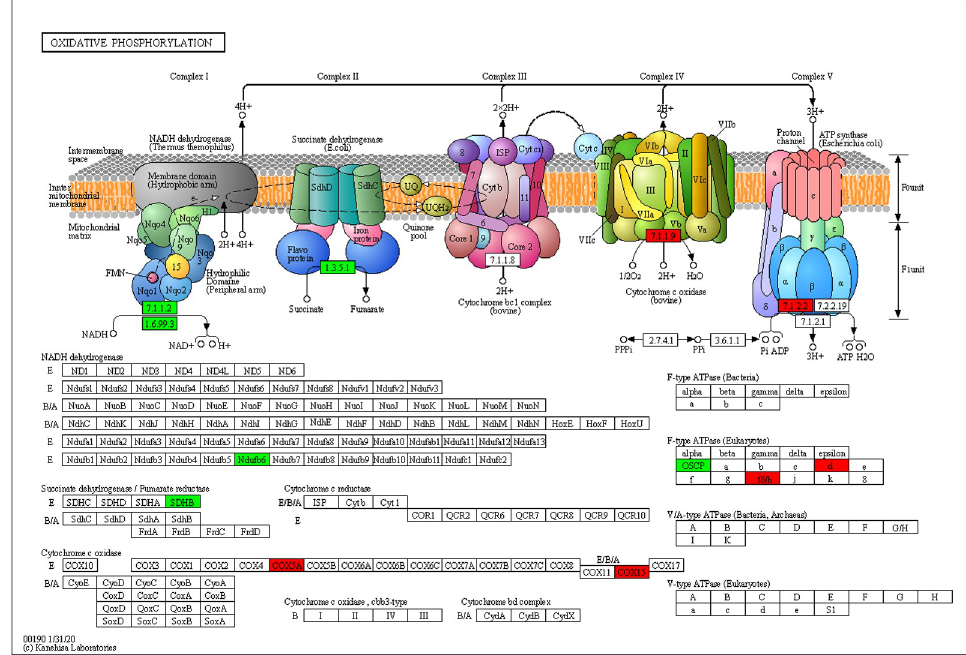
Fig 3. C . parvum affected the oxidative phosphorylation process of host cells. The protein names in red showed upregulated levels and those in green showed downregulated levels in C . parvum -infected HCT-8 cells compared with uninfected